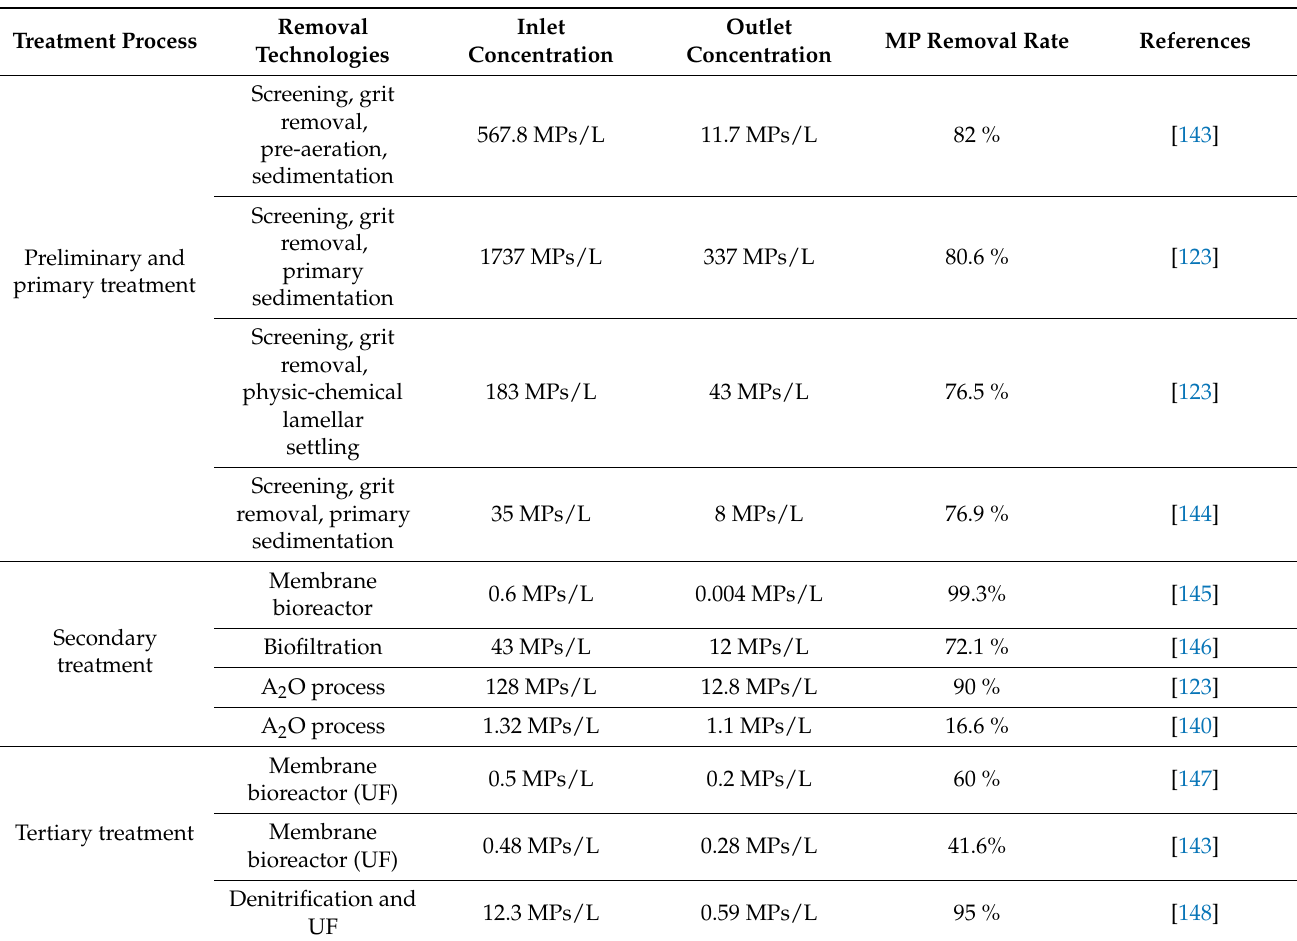
Table 8. Microplastic-removal reviews in